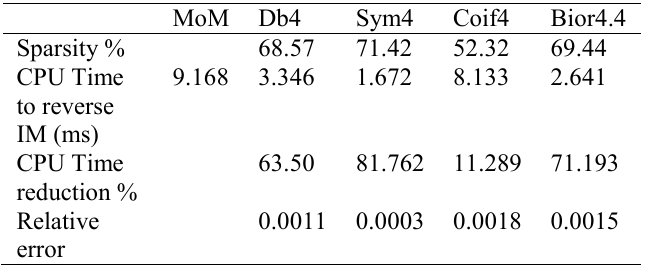
Table 1: Execution times, sparsity and relative error versus